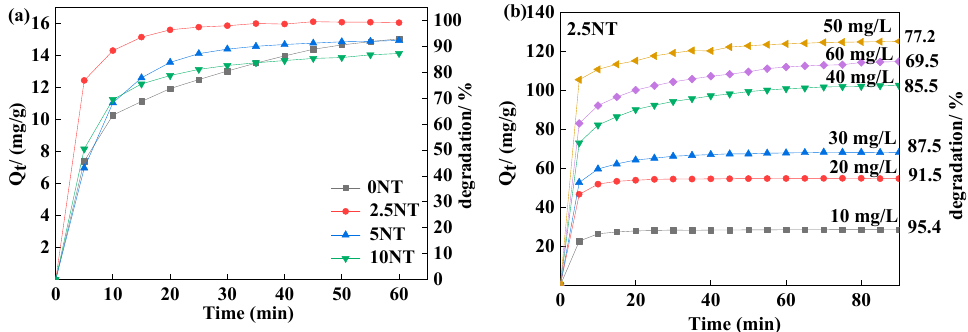
Figure 7. Adsorption curves of the samples. ( a ) All samples, at a MB concentration of 5 mg/L; ( b ) 2.5TNT, at different MB concentrations.